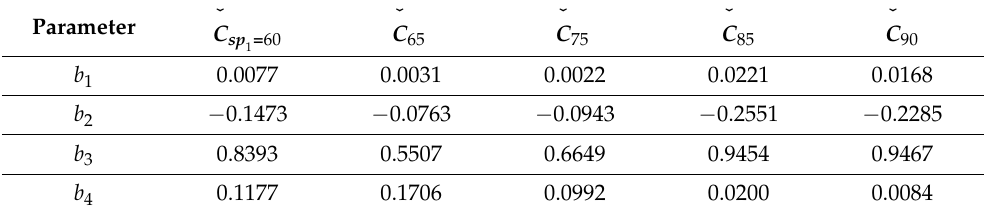
parameters’ values (procedure 4). 1